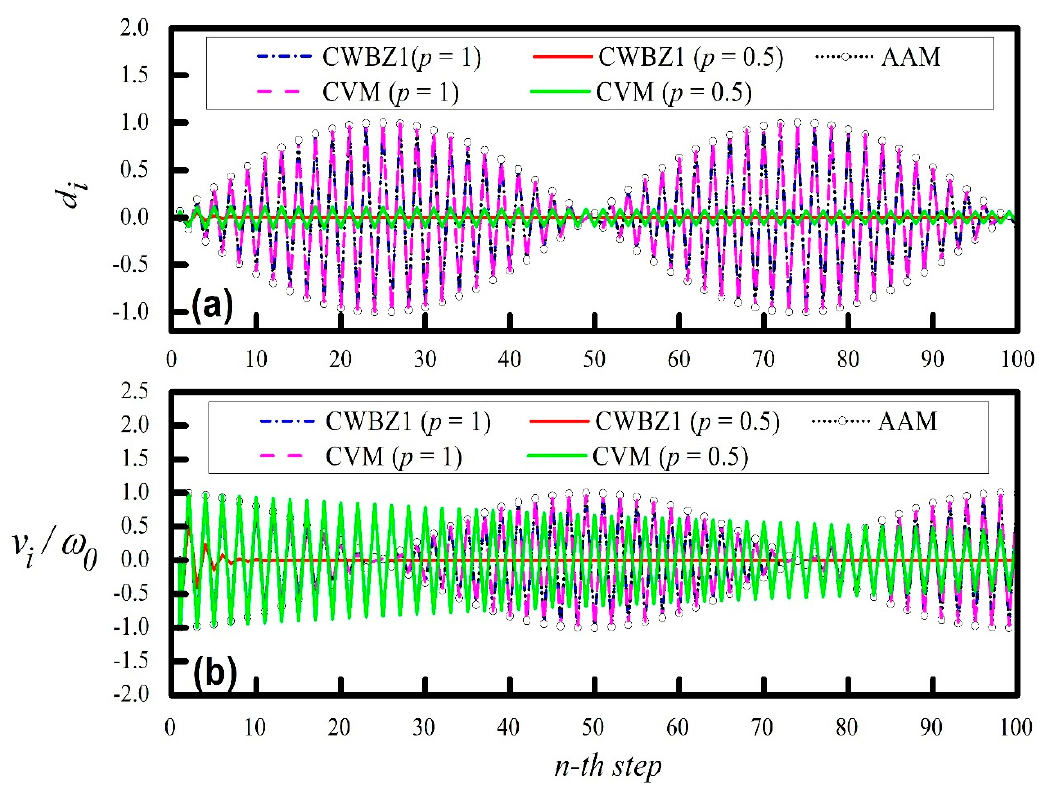
Figure 6. Comparison of the overshoot response of CVM for the second initial conditions.